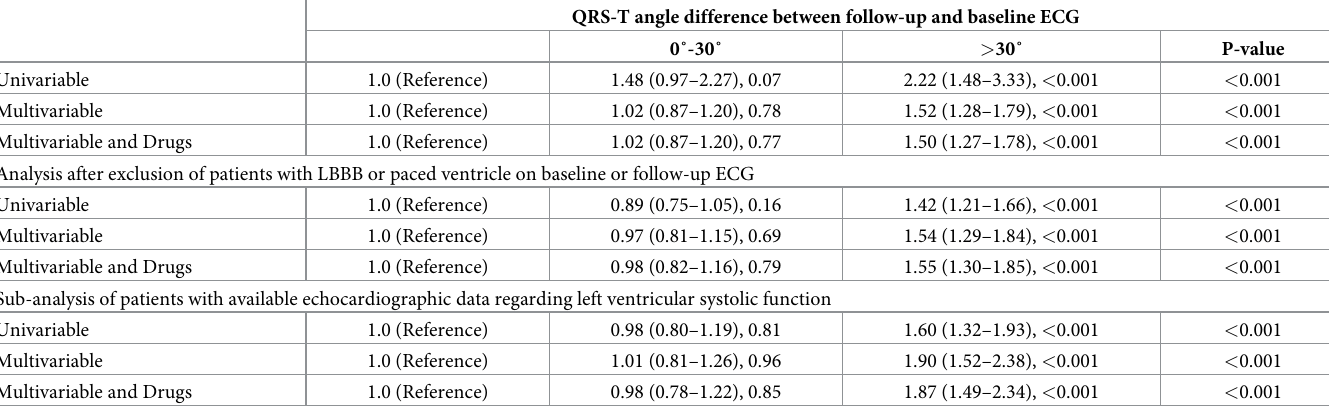
Table 4. Hazard ratio for mortality according to the difference in QRS-T angle between follow-up and baseline ECG by Cox regression analysis.